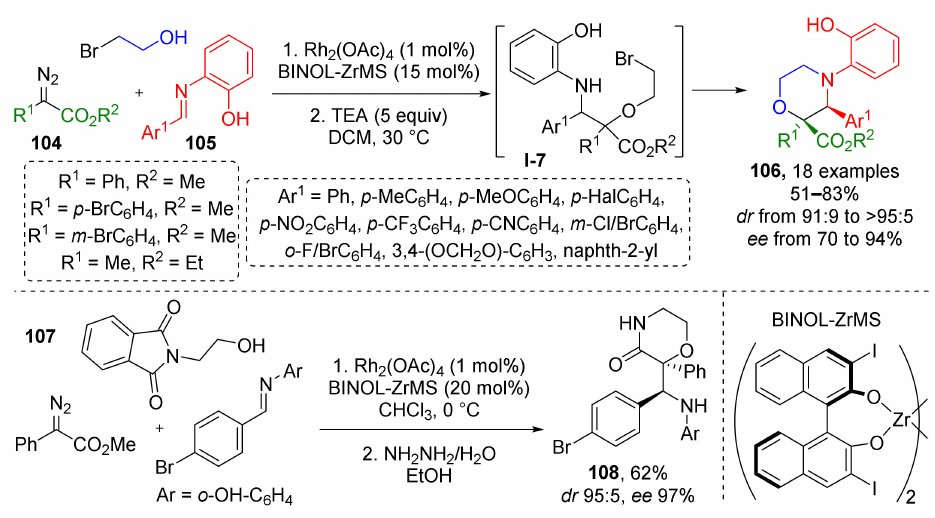
Scheme 30. Three-component reactions of alcohols, diazo compounds, and aldimines with one-pot subsequent cyclization to